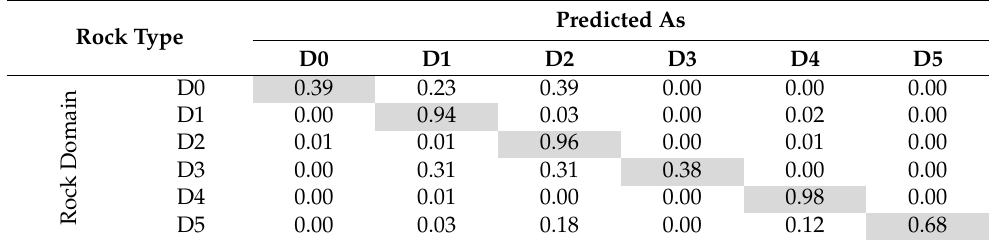
Table 13. Confusion matrix for 3D RF modeling for CEN.